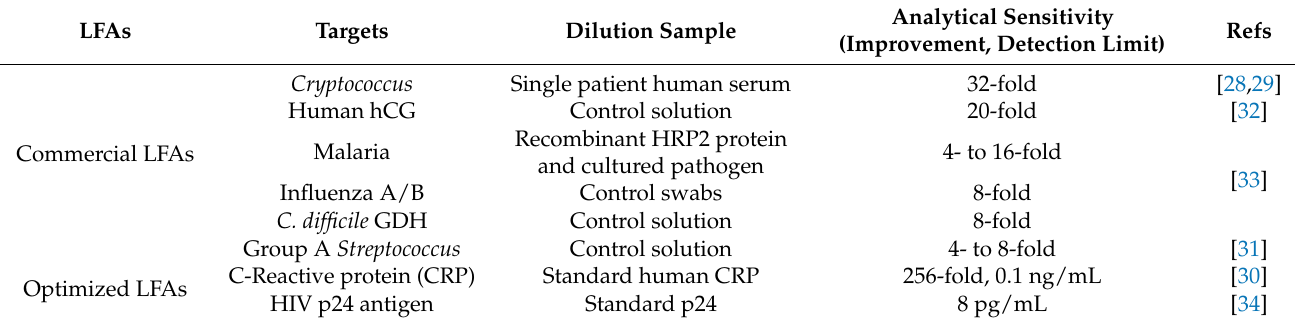
Table 1. Previous publications to evaluate TCA performance through laboratory dilution studies of pure antigen control samples.